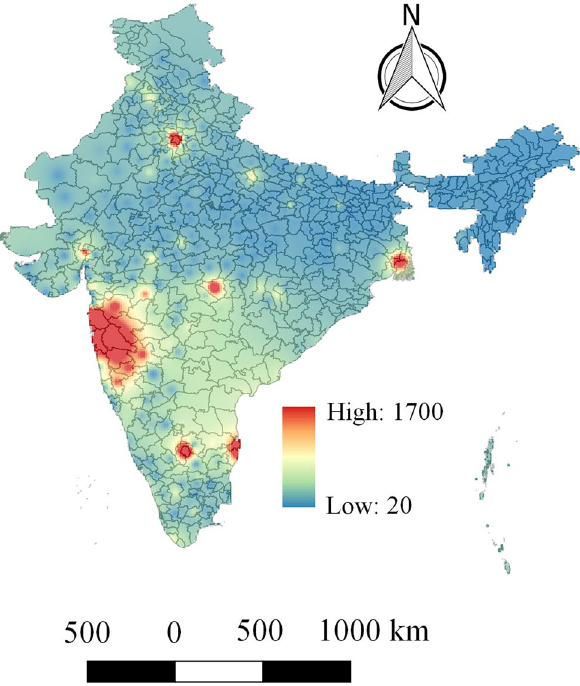
Figure 1. Geographical distribution of COVID-19 deaths across India. The spatially continuous distribution map is generated in QGIS (https:// qgis. org/ en/ site/) by using Inverse Distance Weighting (IDW)